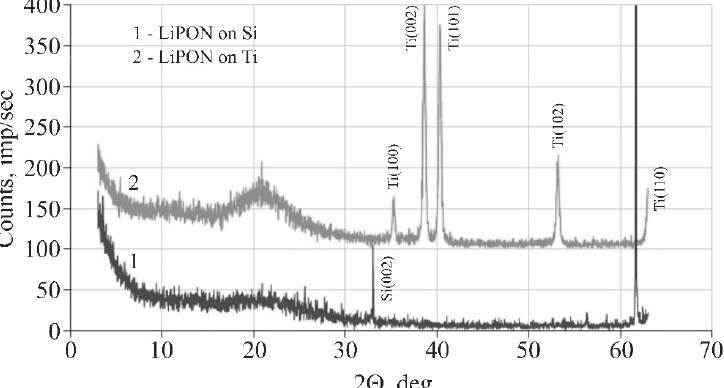
Figure 3. X-ray diffraction patterns of amorphous LiPON films on silicon wafer 1 and on titanium foil 2. The peaks in both curves belong to the substrates, while the amorphous LiPON gives a small halo in the region of peaks 2 Θ = 22.34 ◦ and 2 Θ = 23.19 ◦ .